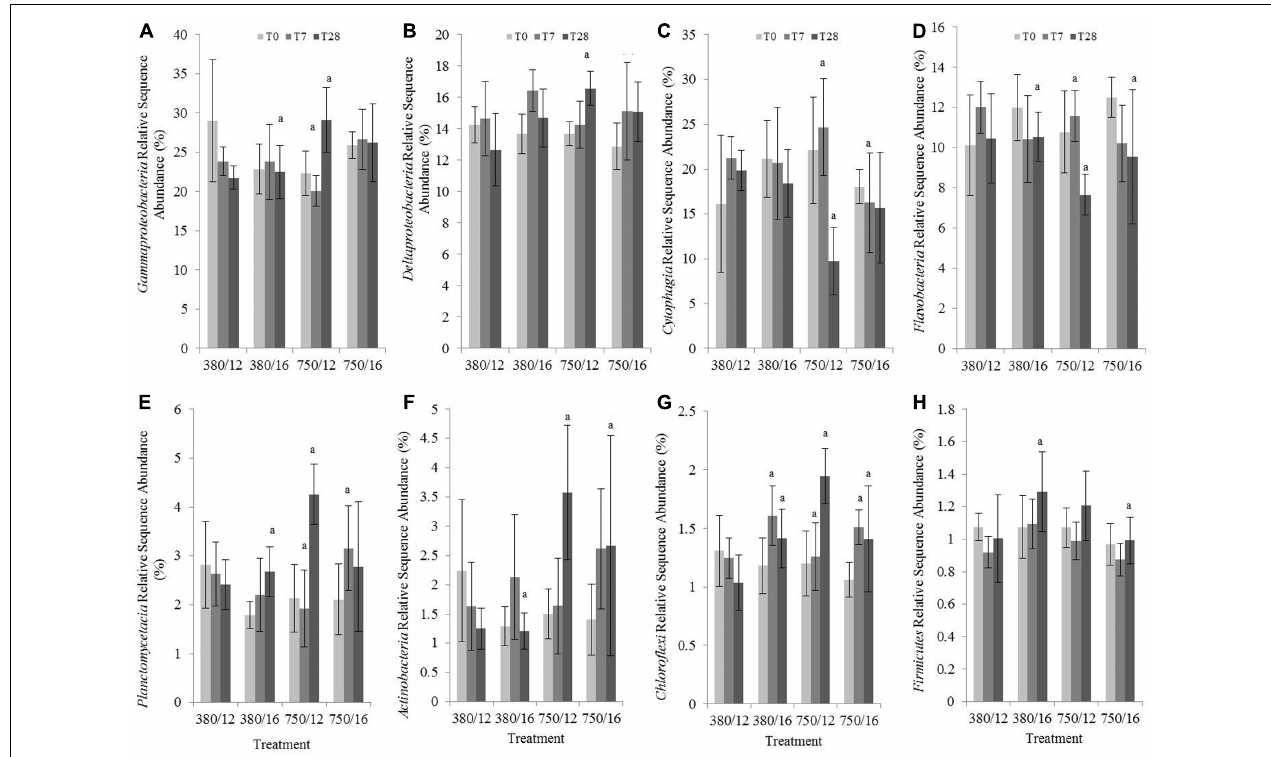
FIGURE 6 | The effects of CO 2 and/or temperature on the relative sequence abundance (%) of (A) Gammaproteobacteria, (B) Deltaproteobacteria, (C) Cytophagia, (D) Flavobacteria, (E) Planctomycetacia, (F) Actinobacteria, (G) Chloroflexi, (H) Firmicutes in muddy sediment. Four syringe cores were taken at each time point (T0, light gray; T7, dark gray; and T28, black) from each environmental treatment ( x -axis). Significant effects from the model output are indicated by the letter a (where there is an interaction with day); b (interaction between elevated CO 2 and elevated temperature). Error bars represent standard deviation of repeated measurements ( n = 4) from treatment replicates ( n =